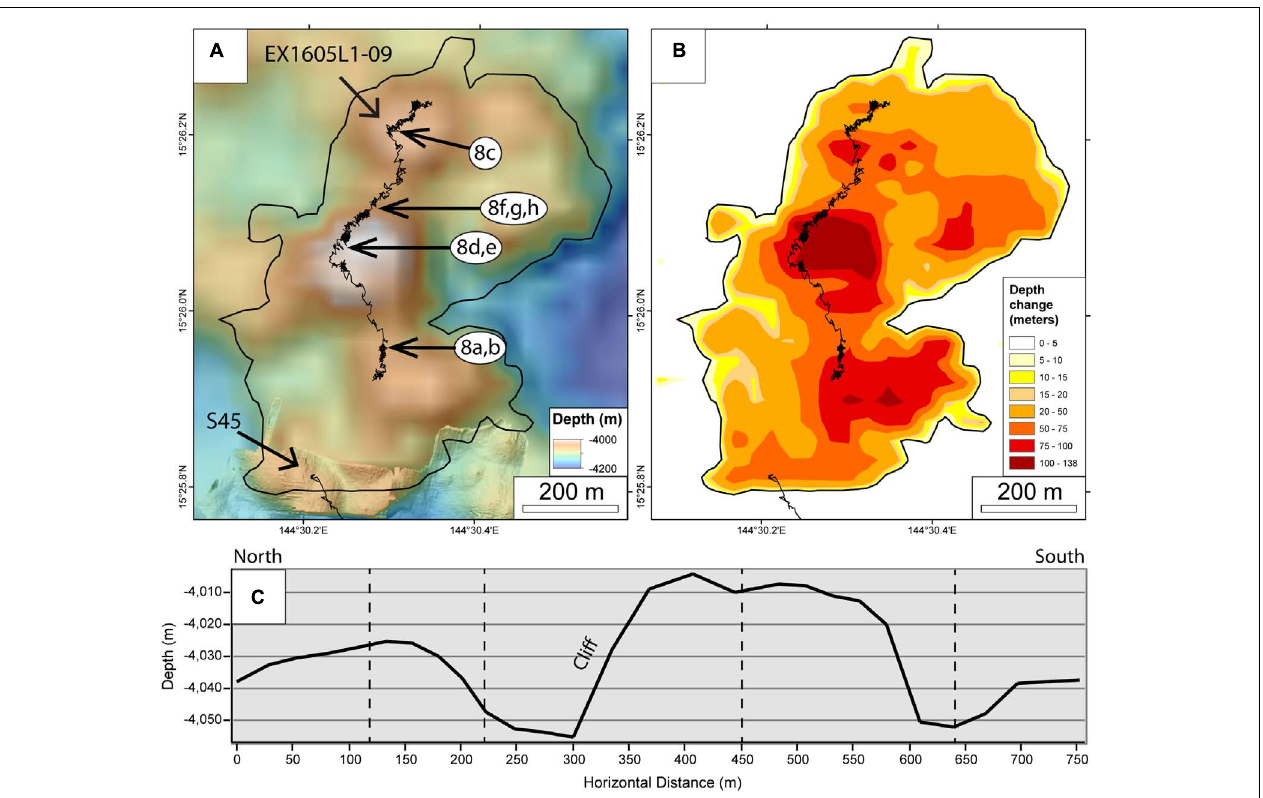
FIGURE 7 | Detailed maps showing the track of ROV Deep Discoverer dive EX1605L1-09 (black squiggly line) across northern-most and thickest lava flow. (A) Bathymetric map, mostly ship-based data (40-m resolution) with a small sliver of AUV Sentry data (1-m resolution) at bottom. Arrows with numbers show locations of ROV images in Figure 8 . (B) Depth changes between ship-based bathymetric surveys in 2013–2015. (C) Depth profile along ROV dive EX1605L1-09 track line, showing 3 haystack-shaped pillow mounds (ship-based bathymetry). Vertical dashed lines indicate major bends in the dive